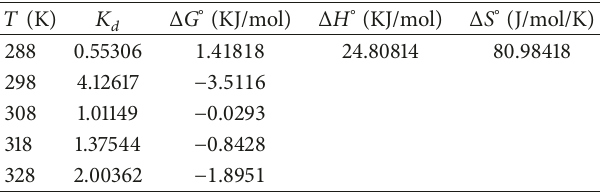
Table 2: Thermodynamic parameters for Cd (II) ions adsorption by polyelectrolyte-coated fly ash